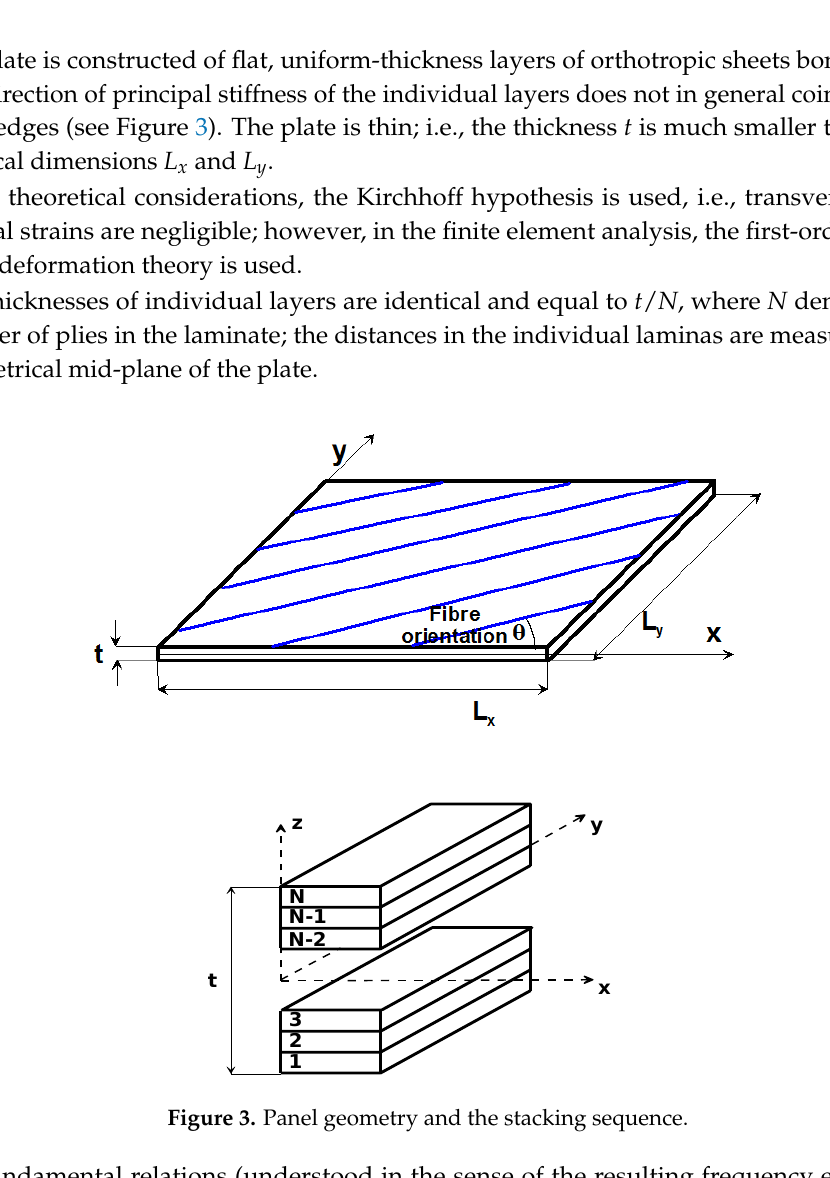
Figure 2. Tapered composite structure.